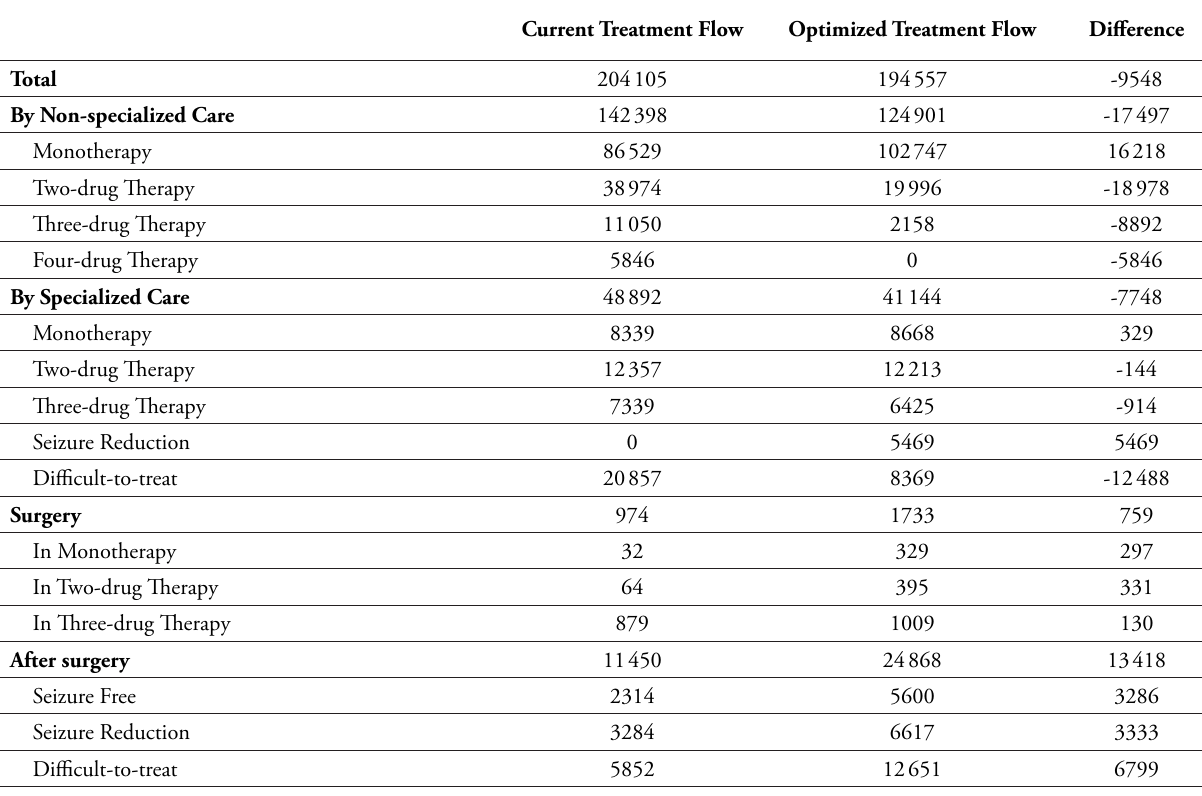
Table 6: Results of Base-case Analysis for Annual Cost (million JPY)